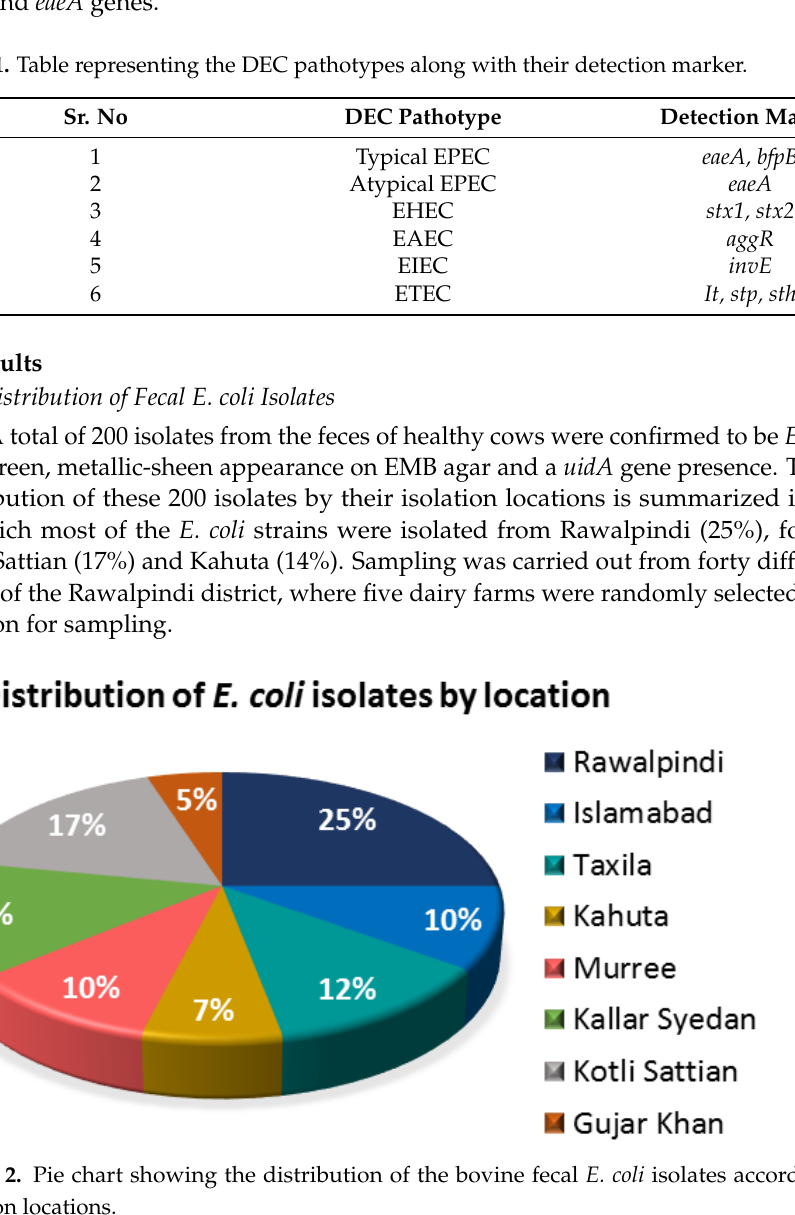
Table 1. Table representing the DEC pathotypes along with their detection marker.